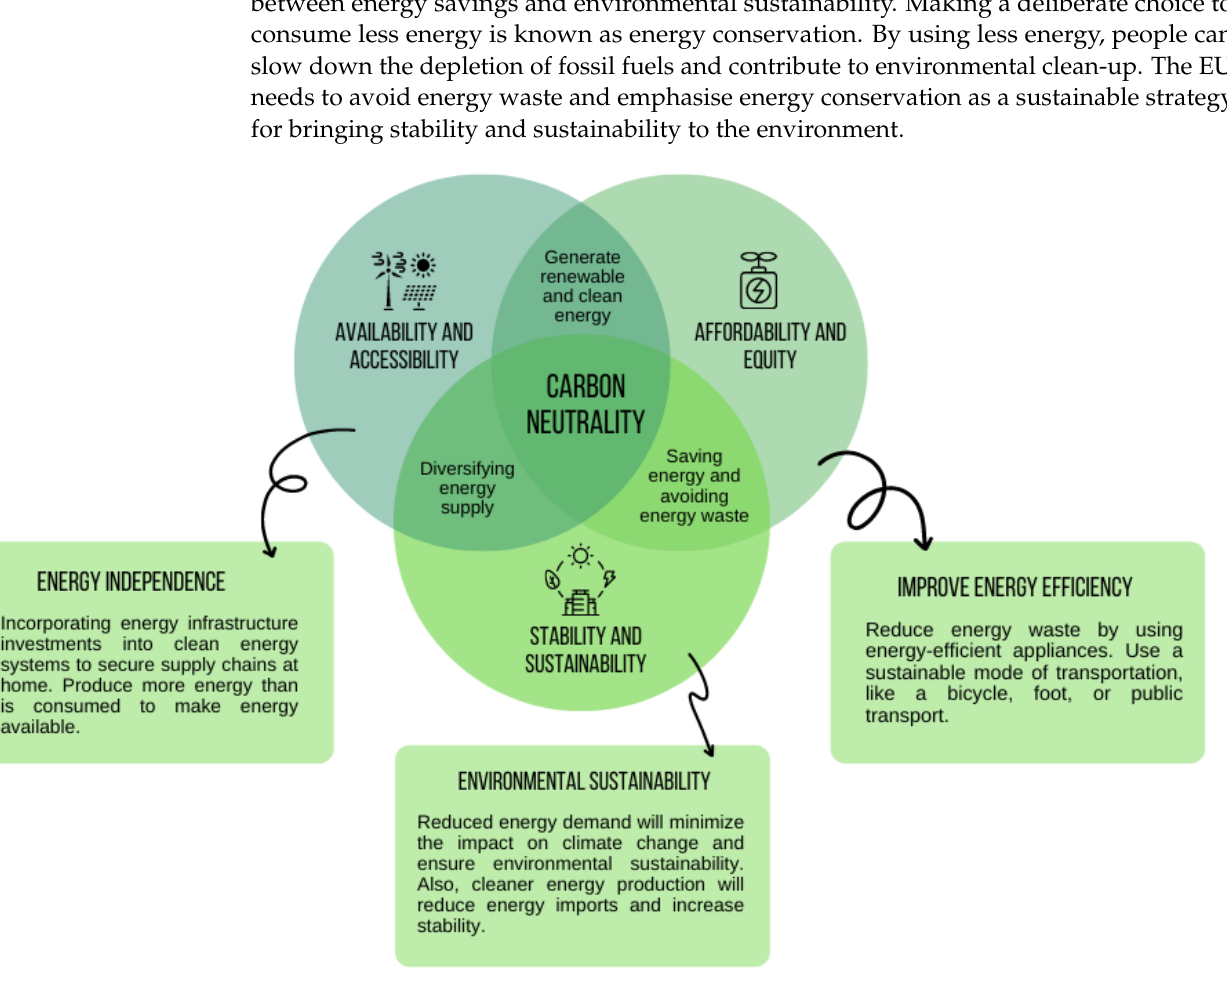
Figure 4. The energy transition towards carbon neutrality. Source: Developed by Authors, based on energy security pillars and RePowerEu plan.